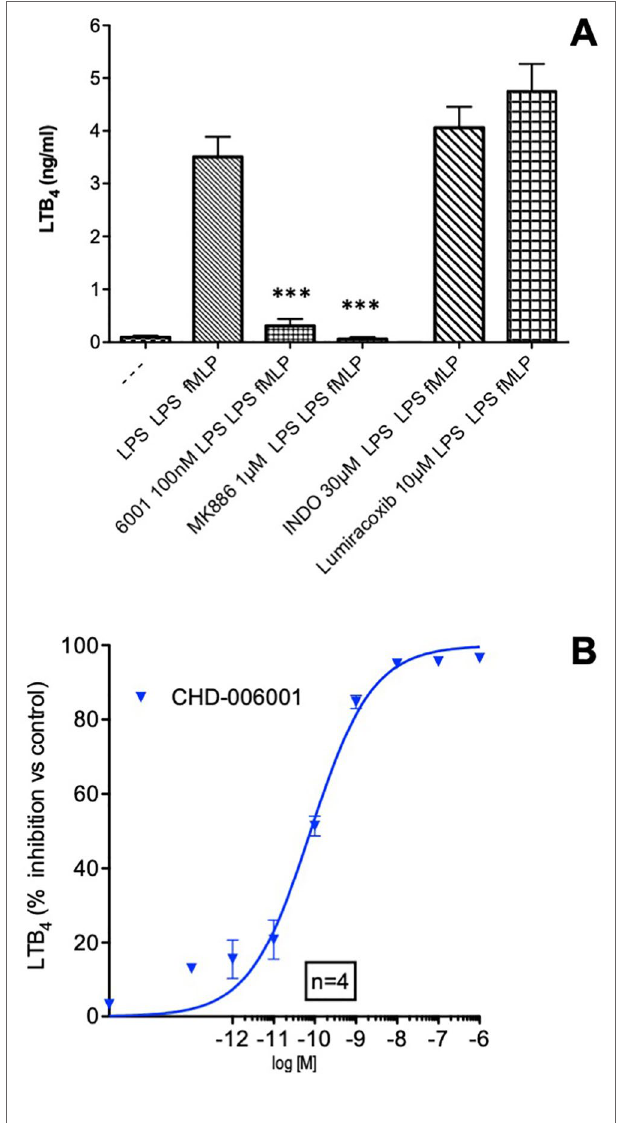
FIGURE 1 | LTB 4 inhibition by CHF6001. (A) Human blood was treated with LPS (1 µg/ml) in the presence or absence of different compounds, followed by lipopolysaccharide (LPS) again after 24 h and the formylated tripeptide N -formyl--methionyl--leucyl-phenylalanine (fMLP, 1 µM) as described in METHODS . LTB 4 production was assessed by LC/MS/MS using stable isotope dilution. (B) Concentration–response curve of the inhibitory effect of CHF6001 on LTB 4 production by LPS/LPS/fMLP activated human blood, assessed by LC/MS/MS using stable isotope dilution. Values are shown as the mean ± SEM, n = 4 for each group. *** P < 0.001 versus LPS group (Dunnett’s test). Sigmoidal dose–response curve was obtained using GraphPad Prism